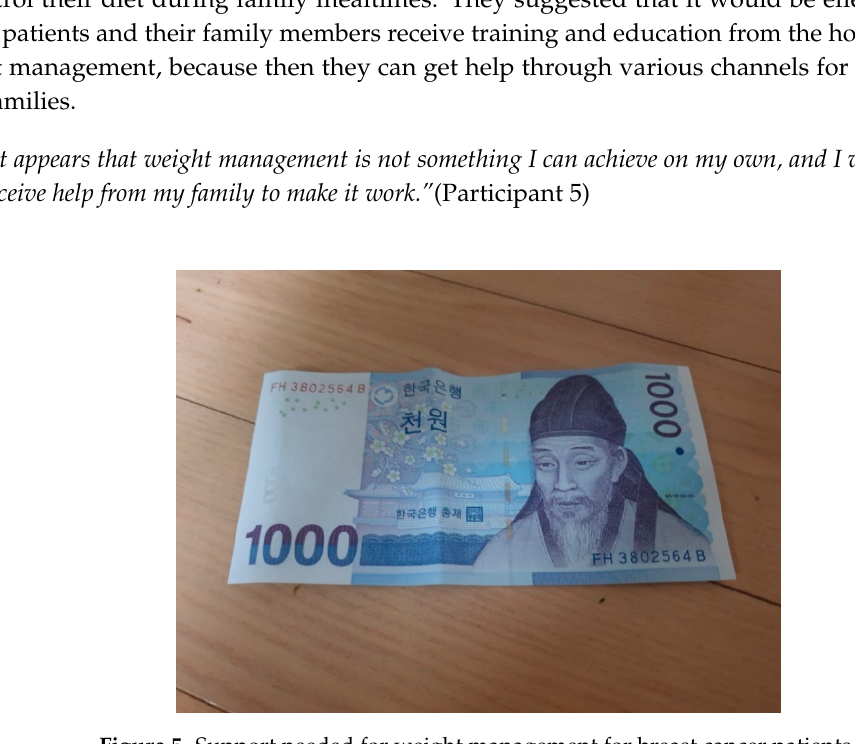
Figure 5. Support needed for weight management for breast cancer patients.